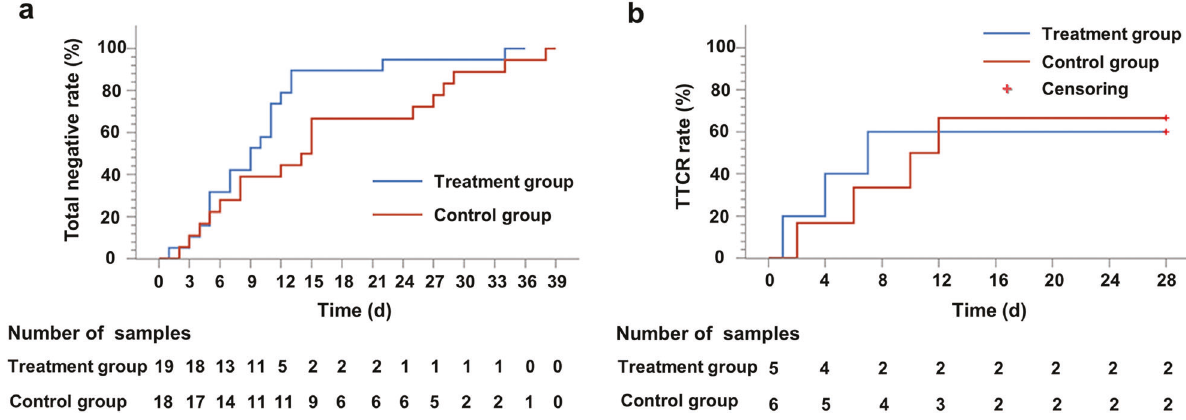
Fig. 3 Outcomes over time. a Total rate of converting to negative throat swab of SARS-CoV-2; b TTCR rate nel fi navir group, whereas three individuals in the control group were abnormal and clinically signi fi cant, with no discernible difference between the two groups statistically. On the 14th day of treatment for patients with mild COVID-19, there were no subjects in either the nel fi navir group ( N = 5) or the control group ( N = 4) progressed to severe or critical pneumonia. Signi fi cantly shortened the duration of fever time of the nel fi navir treated group 59.5% (22/37) patients had clinically signi fi cant abnormal body temperature ranging between 37.1 and 39.2 (Supplementary